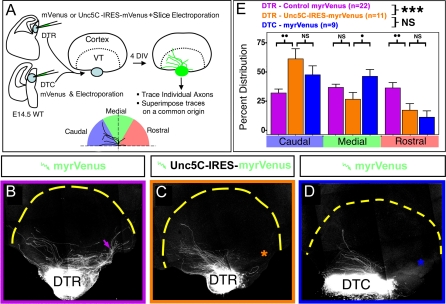
Expression of Unc5C in the Rostral Part of the Dorsal Thalamus Is Sufficient to Induce Repulsion of DTR Axons from Netrin-1–Rich Rostral Domain of the Ventral Telencephalon(A) Experimental approach: E14.5 250-μm–thick slices containing the rostral or caudal domain of the DTh were microinjected and electroporated using a control IRES-myristoylated (m)Venus or a Unc5C-IRES-mVenus expression plasmid. Immediately following electroporation, DTR or DTC explants were isolated and cocultured with a whole-mount telencephalon for 4 d in vitro (DIV). Following fixation and staining with anti-EGFP antibodies, individual DTR or DTC fluorescent axons or fascicles were traced and superimposed on a referenced-plot that was then quantified using ImageJ for optical density distribution in three radial bins. DIV, days in vitro; WT, wild type.(B–D) DTR (B) and DTC (D) axons electroporated with control mVenus-expression plasmid grow preferentially to the rostral and caudal domain of the VTel, respectively. However, DTR axons overexpressing Unc5C grow significantly more caudally than control DTR axons (B) in the VTel, suggesting that Unc5C expression is sufficient to convert DTR into the DTC pattern of axon growth in the VTel.(E) Quantification of the results shown in (B–D) analyzing the percentage of fluorescent axons located in caudal, medial, and rostral bins of the VTelTriple asterisks (***) indicate p < 0.001, ANOVA one-way test (overall effect: bins versus experimental conditions). NS, nonsignificant (p > 0.05); a single dot [•] indicates p < 0.05; and double dots [••] indicate p < 0.01: significance of individual bin comparisons performed between the two experimental conditions using a Fisher PLSD post hoc test.